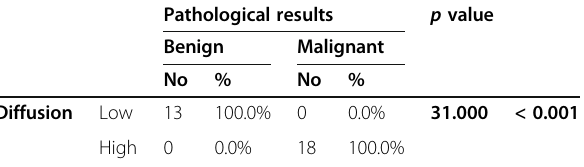
Table 2 Comparison between the two studied groups according to the duration of different parameters